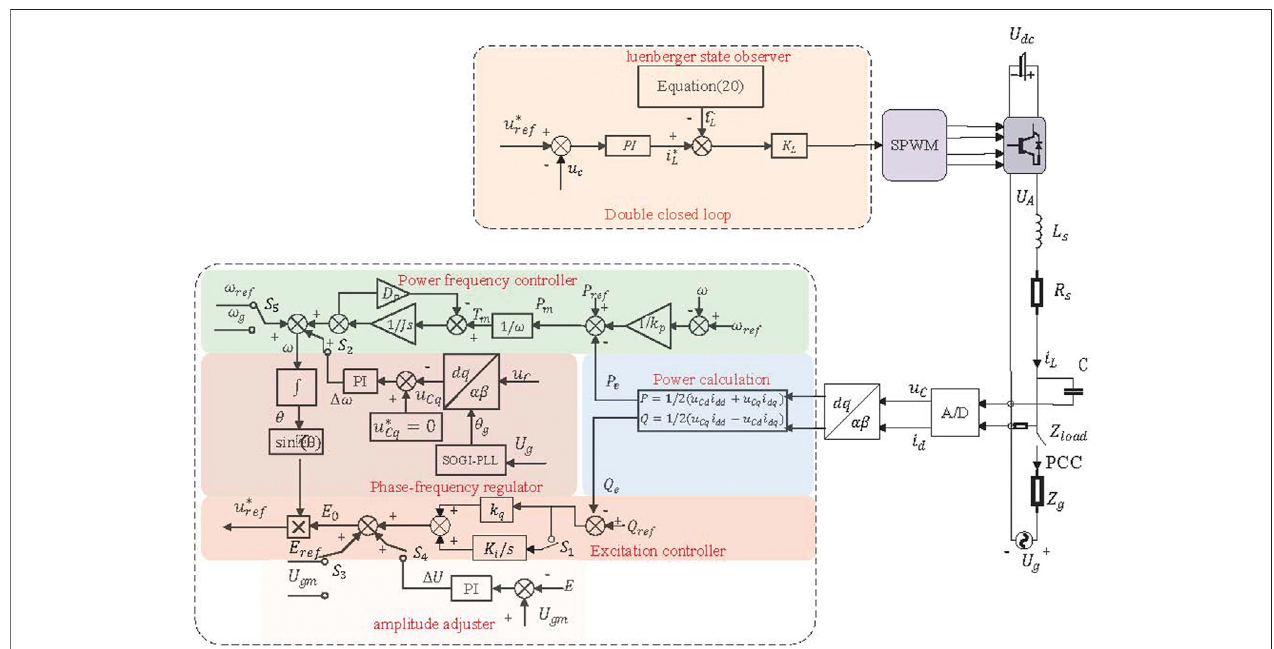
FIGURE 8 | The whole block diagram of the single-phase VSG.